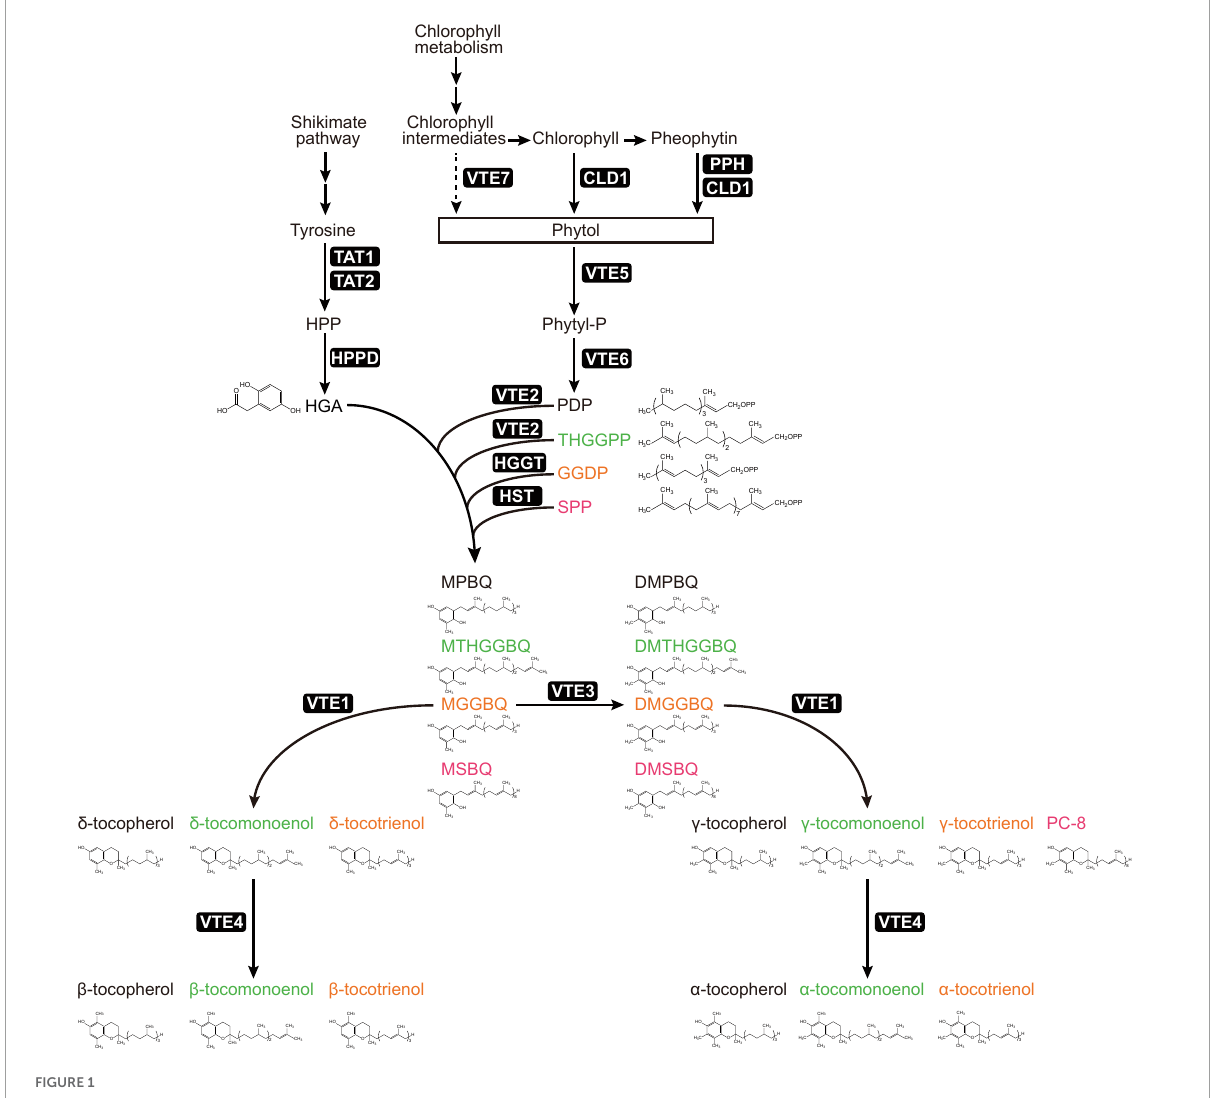
FIGURE1 Plant tocochromanol biosynthesis pathway and sources of metabolites. Metabolite names were colored for recognizing different tocochromanol synthesis pathways. Abbreviations of metabolites: HPP, 4-hydroxyphenylpyruvate; HGA, homogentisate; Phytyl-P, phytyl-phosphate; PDP, phytyl-diphosphate; THGGPP, tetrahydrogeranylgeranyl pyrophosphate; GGDP, geranylgeranyl pyrophosphate; SPP, solanesyl pyrophosphate; MPBQ, 2-methyl-6-phytyl-1,4-benzoquinol; DMPBQ, 2,3-dimethyl-6-phytyl-1,4-benzoquinol. Abbreviations of enzymes: TAT1, tyrosine aminotransferase 1; TAT2, tyrosine aminotransferase 2; HPPD, 4-hydroxyphenylpyruvate dioxygenase; CLD1, chlorophyll dephytylase 1; PPH, pheophytin pheophorbide hydrolase; VTE, vitamin E biosynthetic